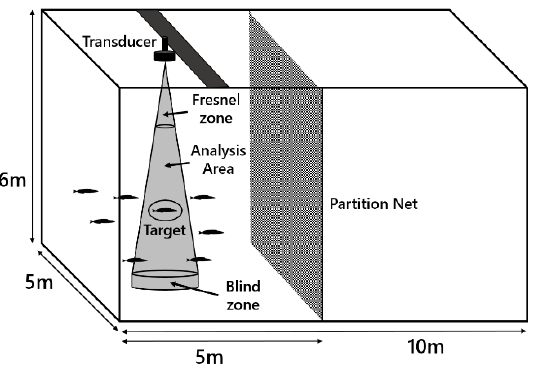
Figure 1. Schematic overview of the indoor large experimental aquarium used for TS measurement of a free-swimming sandeel using a quantitative echo sounder.